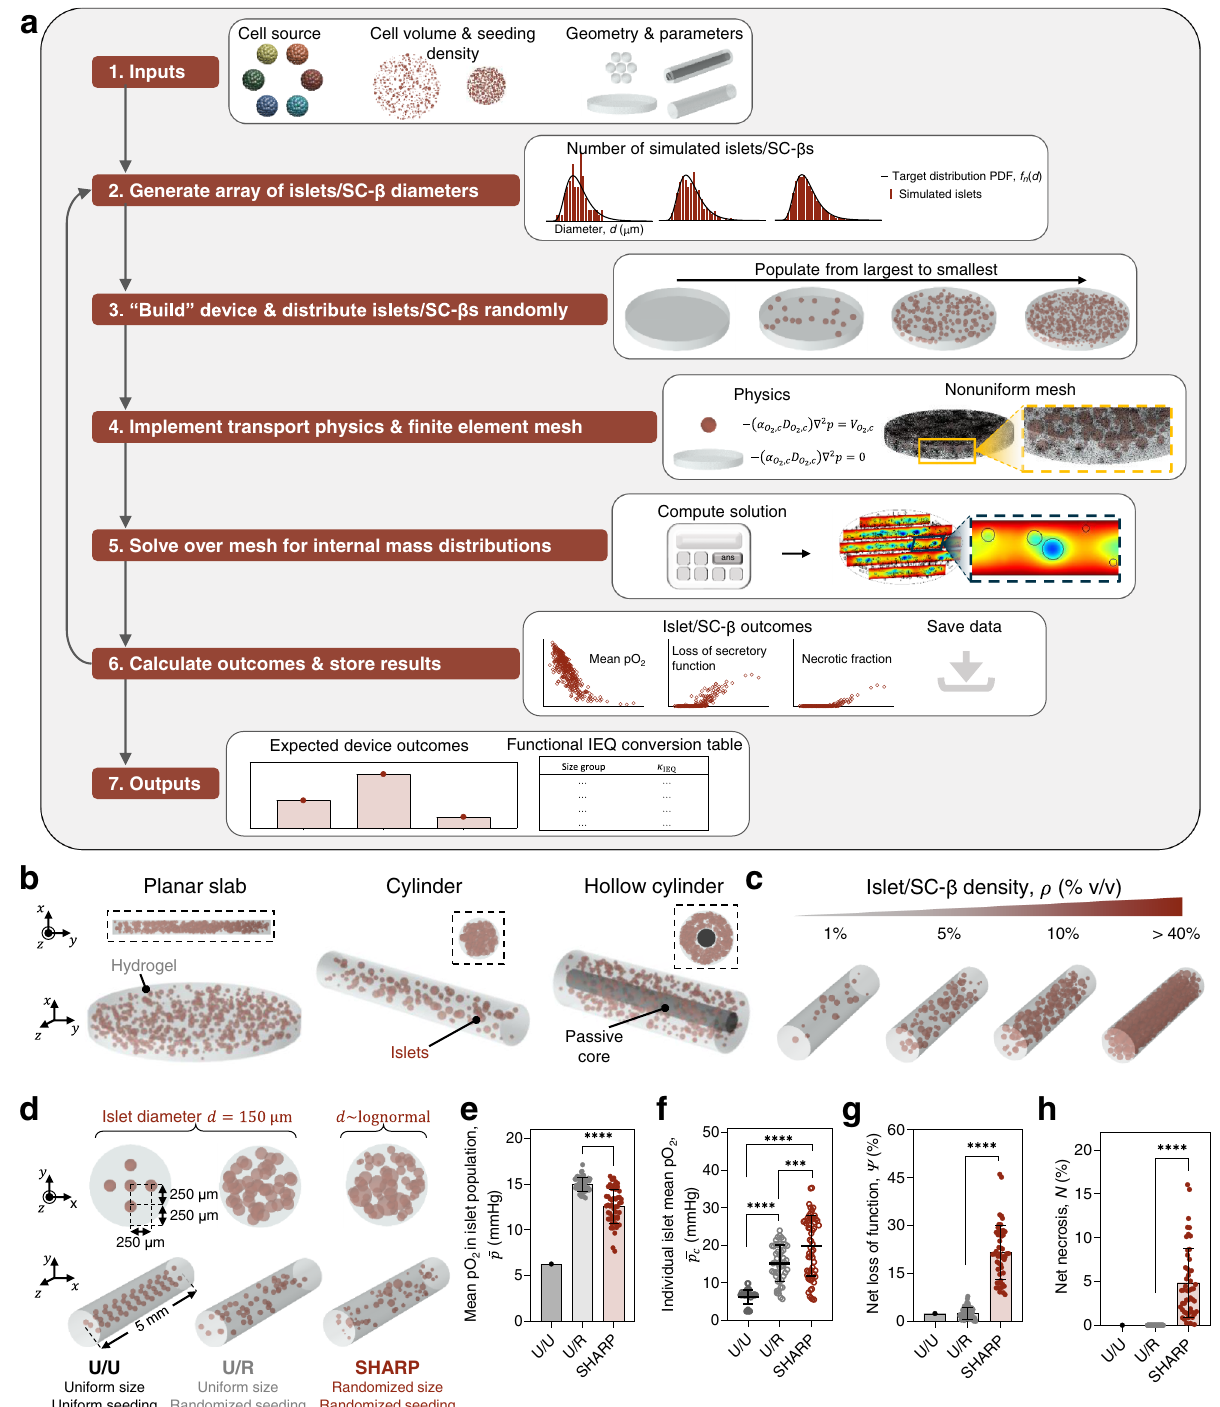
Fig.2|SHARPenablestheevaluationofadiverserangeofbioarti fi